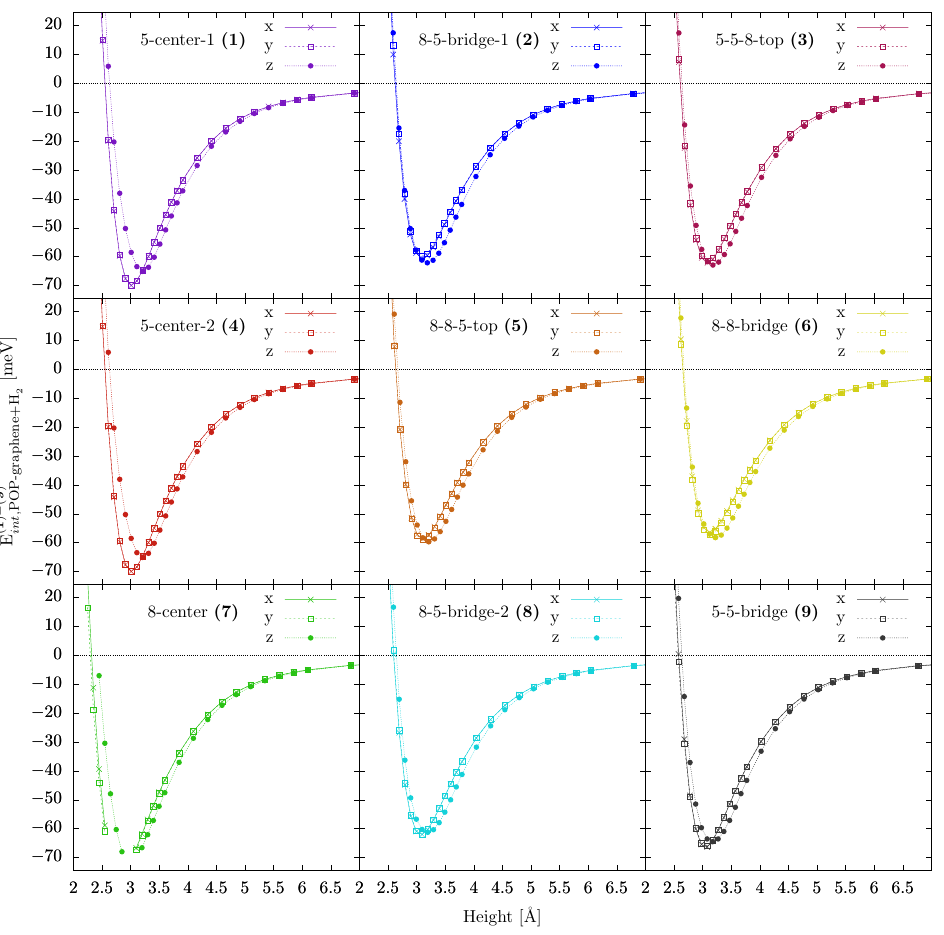
Figure A2. Interaction energies E ( 1 ) − ( 9 ) for (x,y and z) alignment of the H 2 molecule on int ,POP-graphene + H 2 different adsorption sites on POP-graphene (as shown in Figure A1). The colors of the the balls in Figure A1, labelling special positions, corresponds width the colors of the curves. The numbers in the figure titles represents the corresponding carbon structure (5=pentagon, 8=octagon), e.g., 8-8-bridge is bond between two adjacent